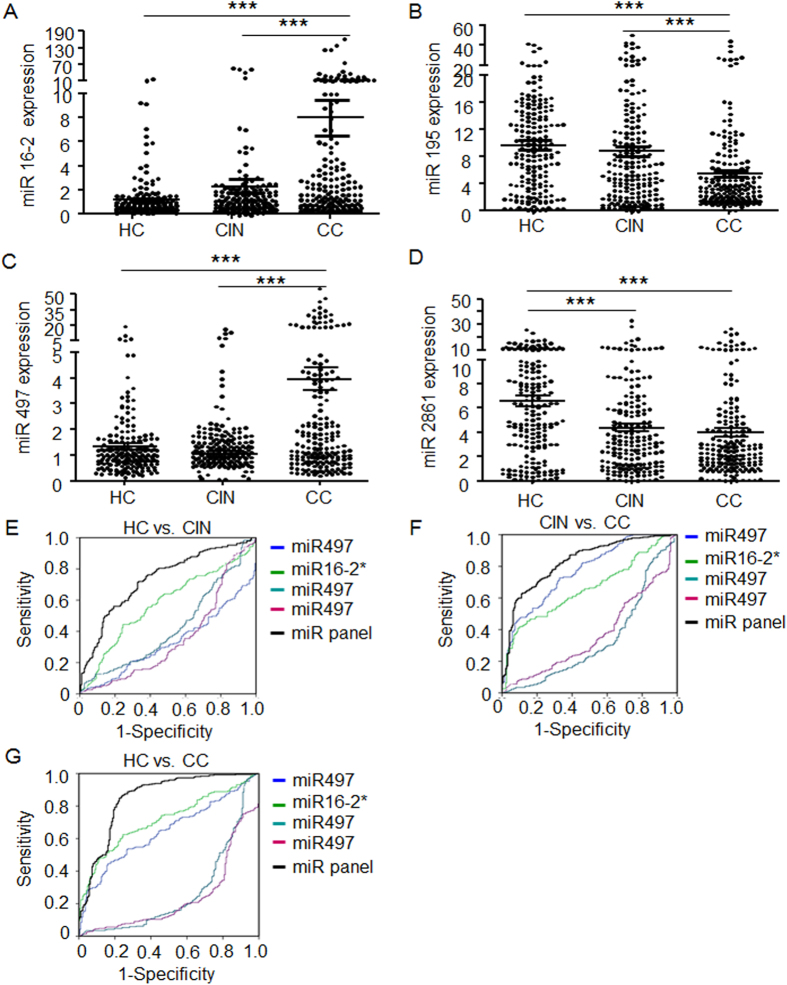
Expression level and diagnosis value of 4 indentified miRNAs for CC and CIN.Relative expression levels of the four miRNAs, including miR-16-2* (A), miR-195 (B), miR-497 (C) and miR-2861 (D) in serum among healthy controls, CIN and CC. ROC analysis with significant miRNAs between CIN and HC (E), CC and CIN (F), and CC and HC subjects (G) were demonstrated accordingly by regression analysis. The value of area under curve (AUC) was showed following each miRNA and a 4 miRs panel. CC, cervical cancer; CIN, cervical intraepithelial neoplasia; HC, healthy subjects. P values were calculated using the Mann-Whitney test. ns, not significant; *p < 0.05; **p < 0.01; ***p < 0.001.